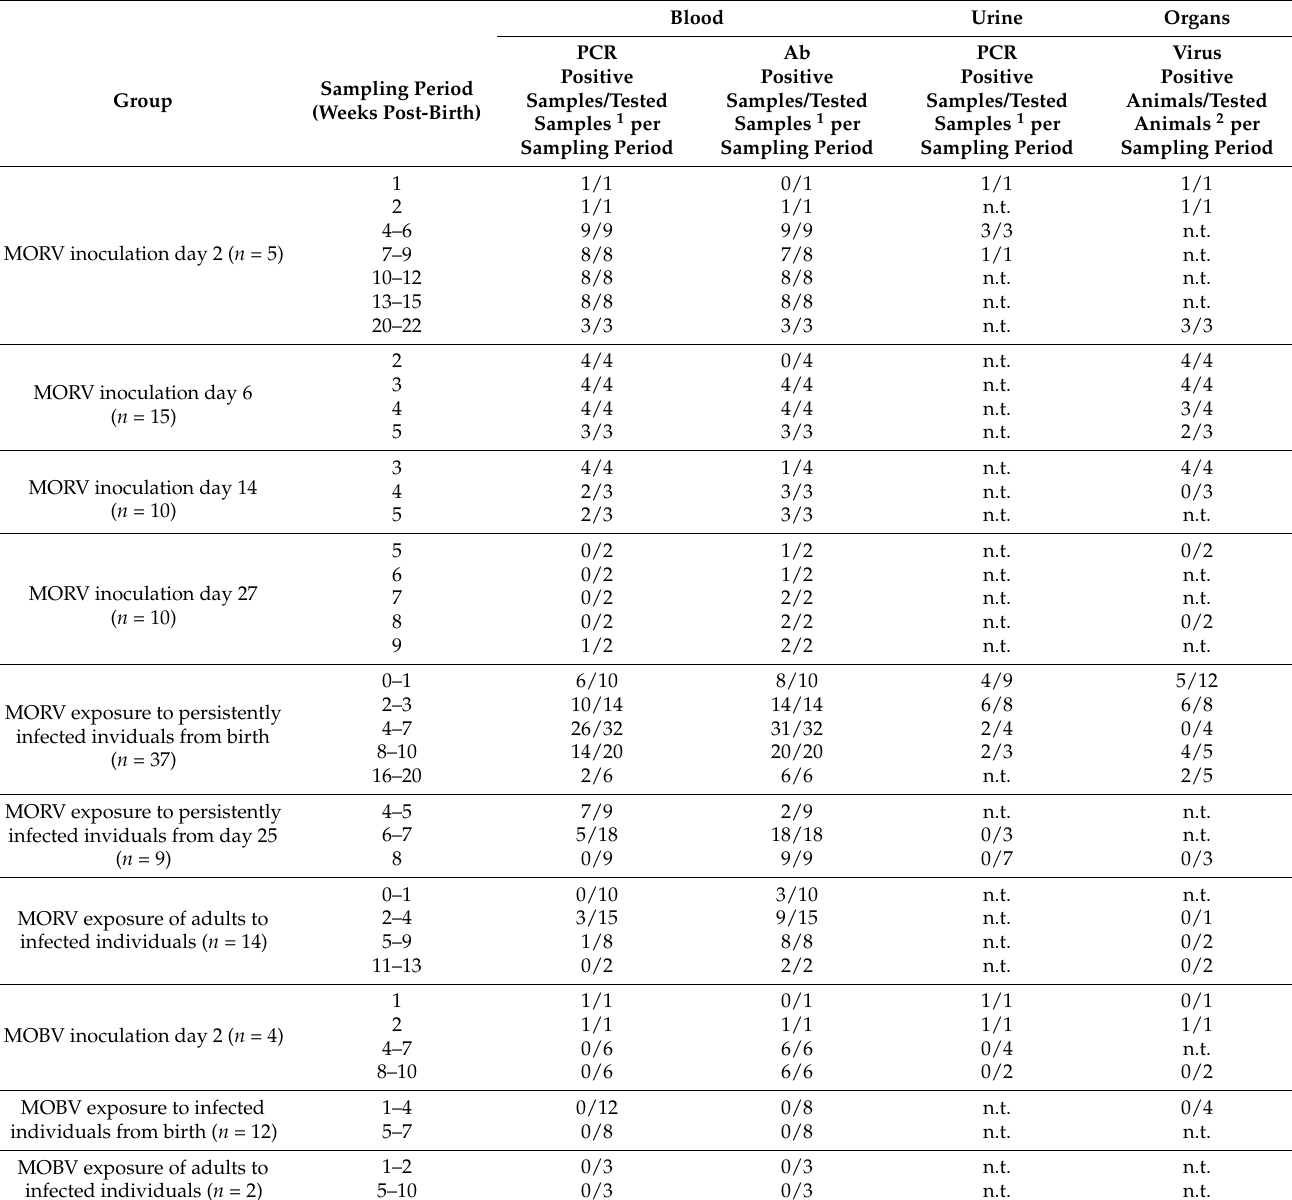
Table 2. Overview of the infection status of Mastomys following inoculation or exposure with Morogoro virus (MORV) or Mobala virus (MOBV).